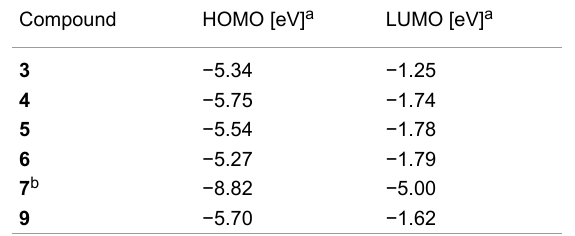
Table 3: Calculated HOMO and LUMO levels of phospholes.